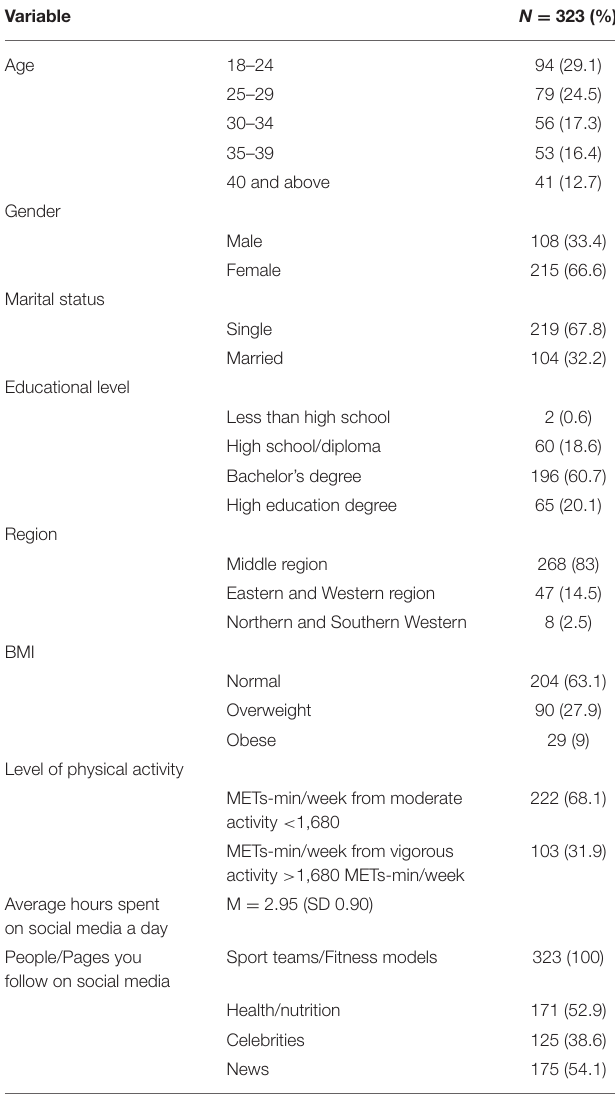
TABLE 1 | Demographic characteristic of the